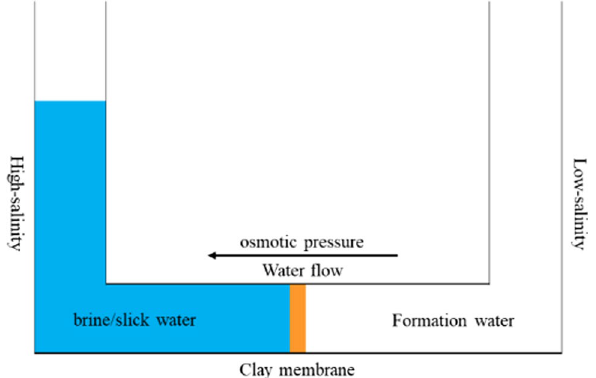
Fig. 8 Schematic diagram of osmotic pressure in high-salinity fluid SI